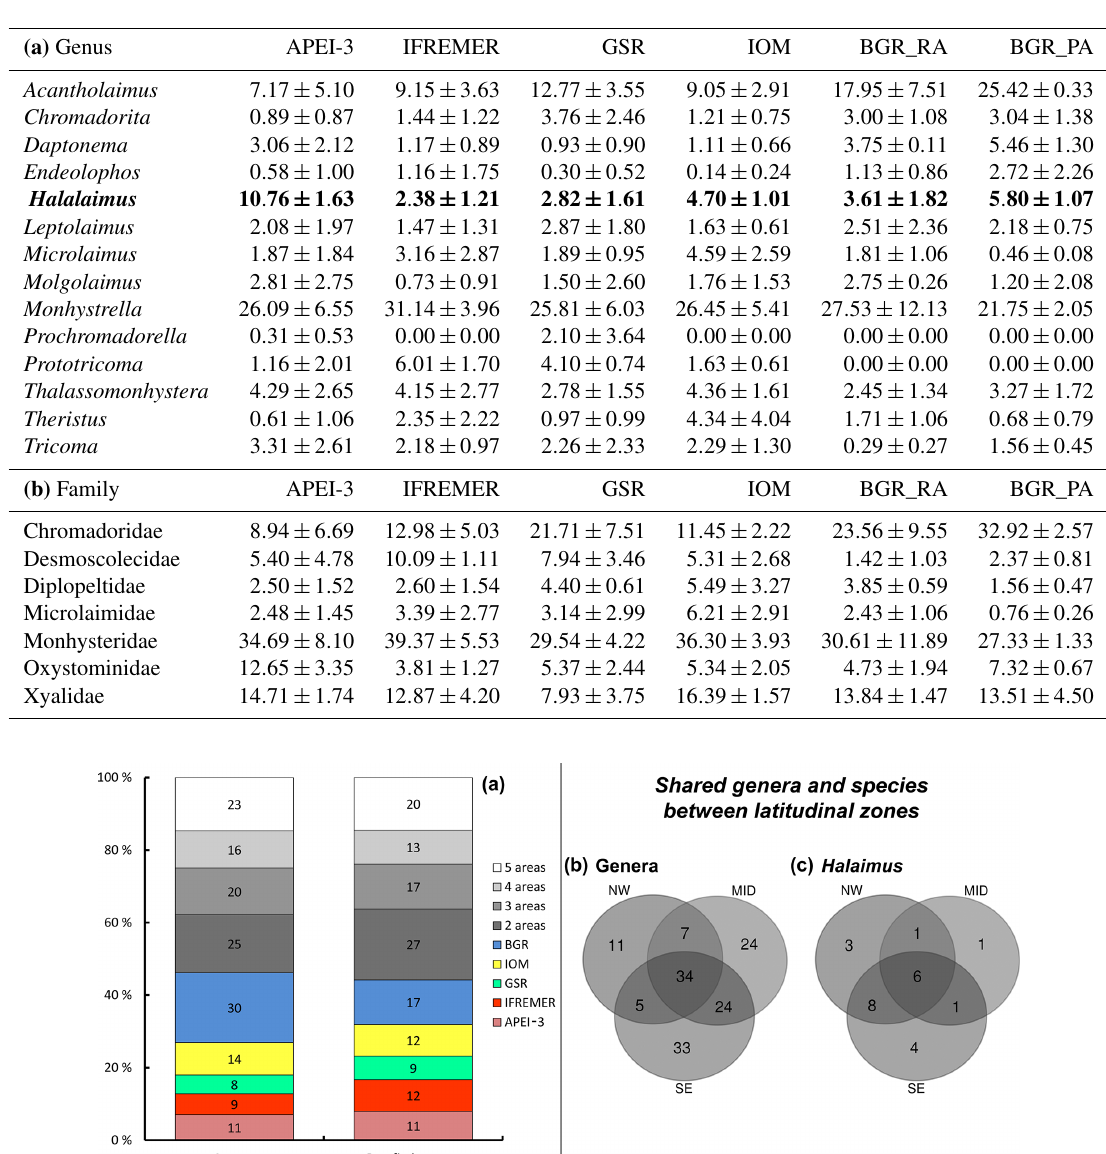
Table 6. Overview of the most abundant genera ( a ; relative abundance > 5% in at least one replicate sample) and families ( b ; average relative abundance > 5% in at least one area) and their average relative abundance ( ± standard deviation) per area. Note that Halalaimus is highlighted with bold font, as this is the genus that was identified up to species level.